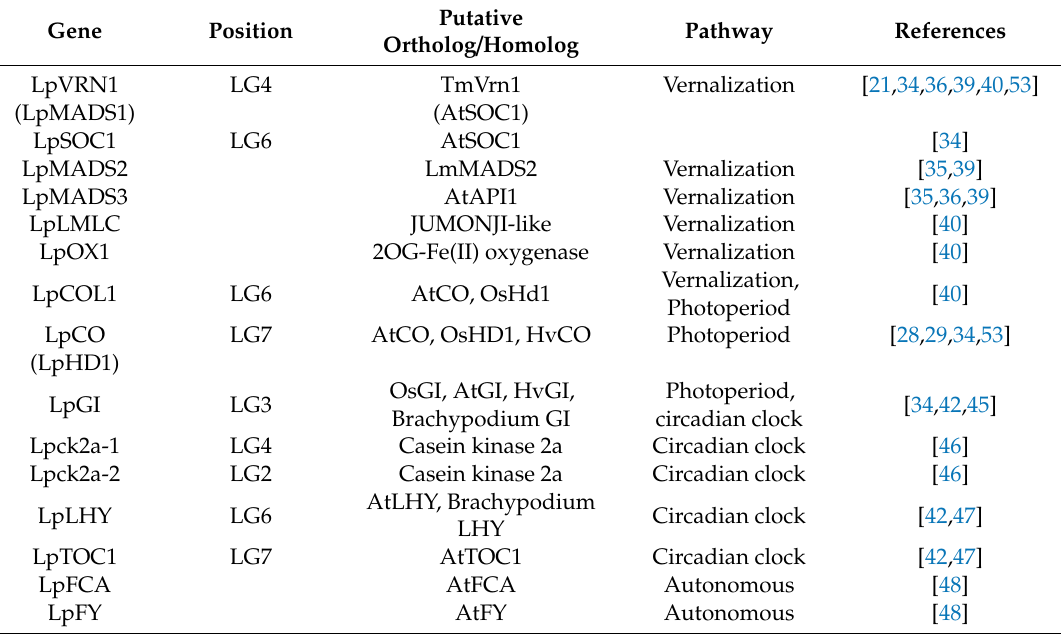
Table 1. Key genes involved in the control of flowering